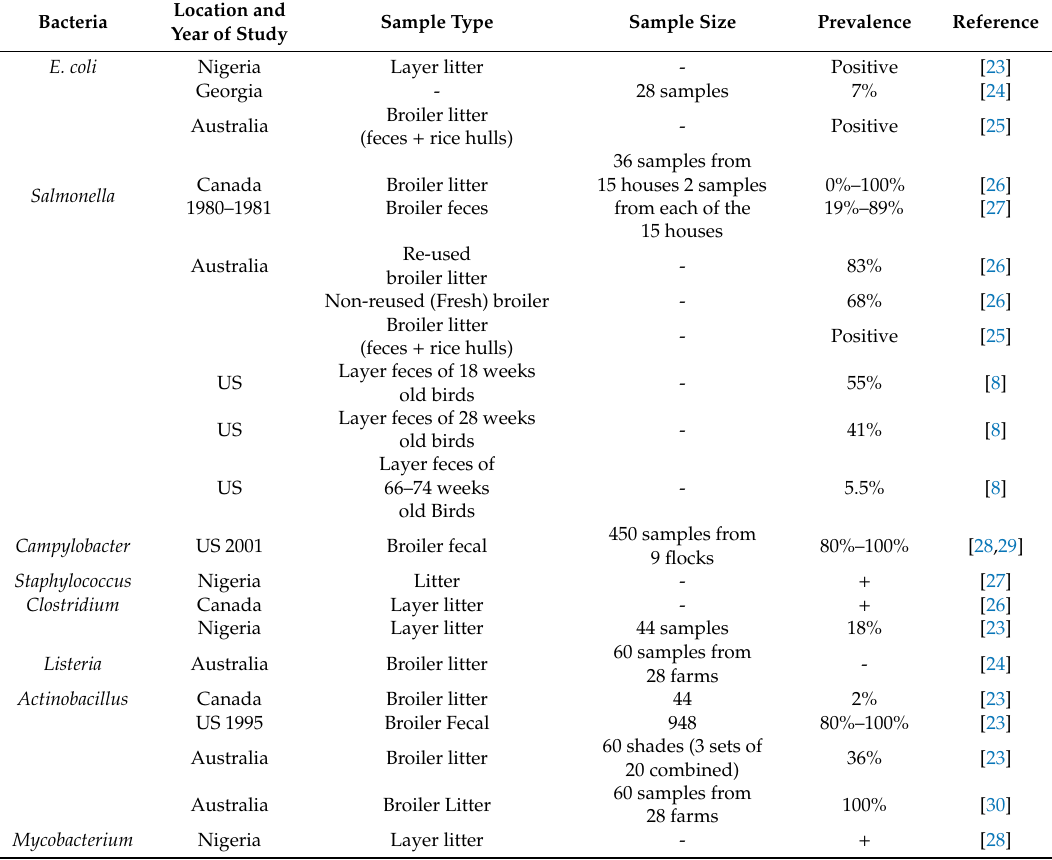
Table 1. Prevalence of food-borne pathogenic bacteria in chicken litter and chicken litter-based organic